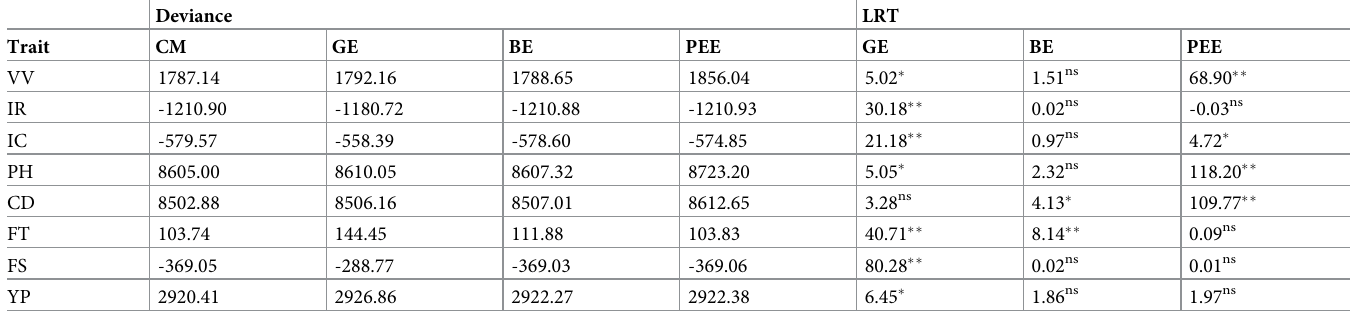
Table 4. Deviance and likelihood ratio test (LRT) for the following traits: Vegetative vigor (VV), incidence of rust (IR), incidence of cercosporiosis (IC), plant height (PH), canopy diameter (CD), fruit ripening time (FT), fruit size (FS), and yield per plant (YP), evaluated in the robusta coffee population. Deviance LRT Trait